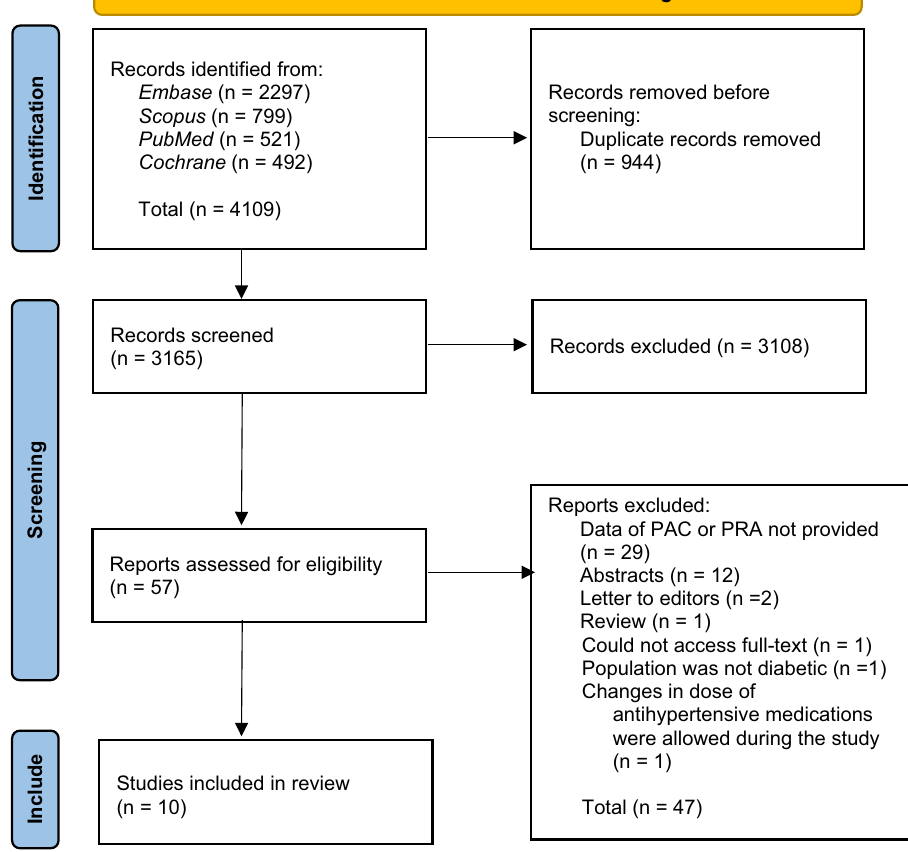
Figure 1. PRISMA Flow Diagram.